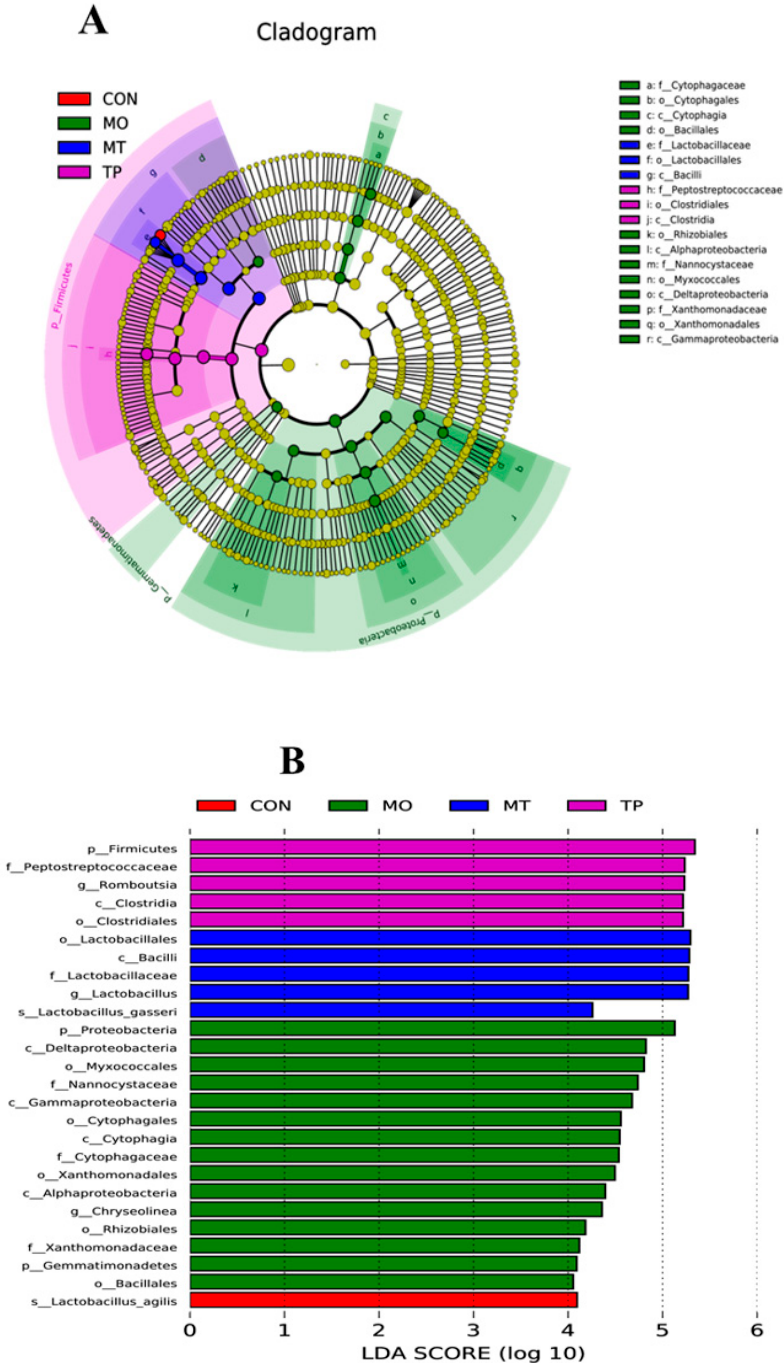
Figure 4. Linear discrimination analysis coupled with e ff ect size (LEfSe) identified the most di ff erentially abundant taxa in the cecum microbiota of MO-fed layers. ( A ) Taxonomic cladogram obtained from LEfSe analysis of 16SrRNA sequencing. Biomarker taxa are heighted by colored circles and shaded areas. Each circle’s diameter is relative to abundance of taxa in the community. ( B ) Only taxa meeting an LDA significant threshold > 3 are shown. (Red) CON enriched taxa; (Green) MO enriched taxa; (Blue) MT enriched taxa; (Purple) TP enriched taxa.